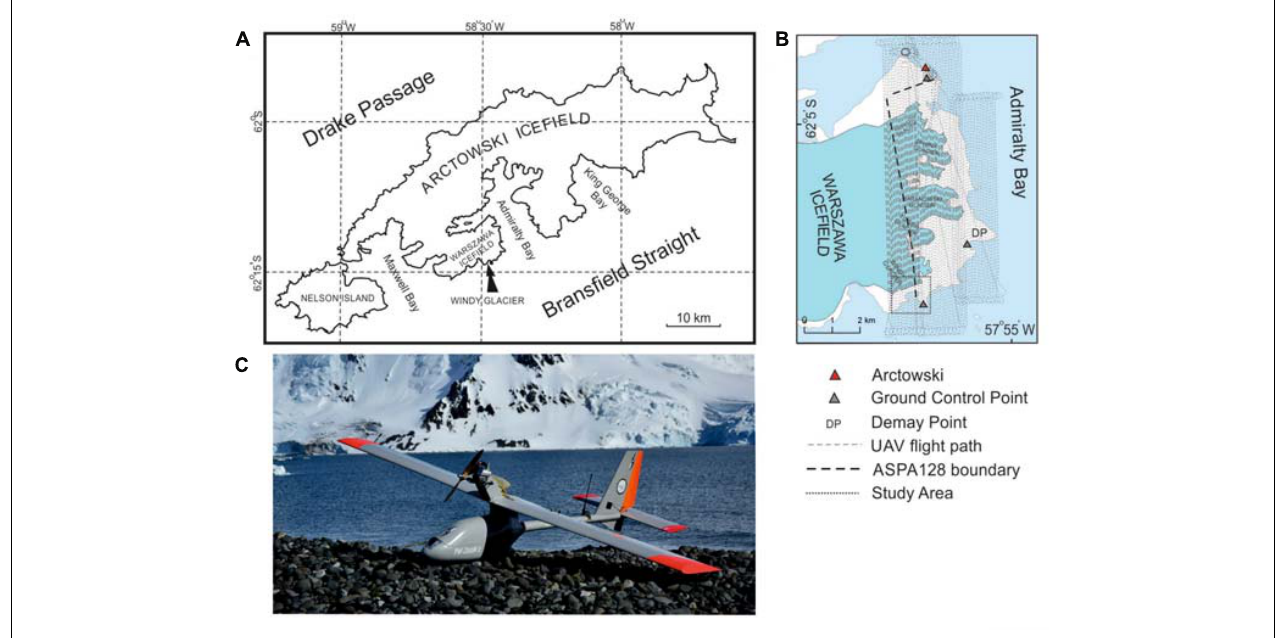
FIGURE 1 | (A) Location of Windy Glacier on King George Island (South Shetland Islands); (B) flight path over ASPA128 and surroundings; (C) PW-ZOOM unmanned aerial vehicle.